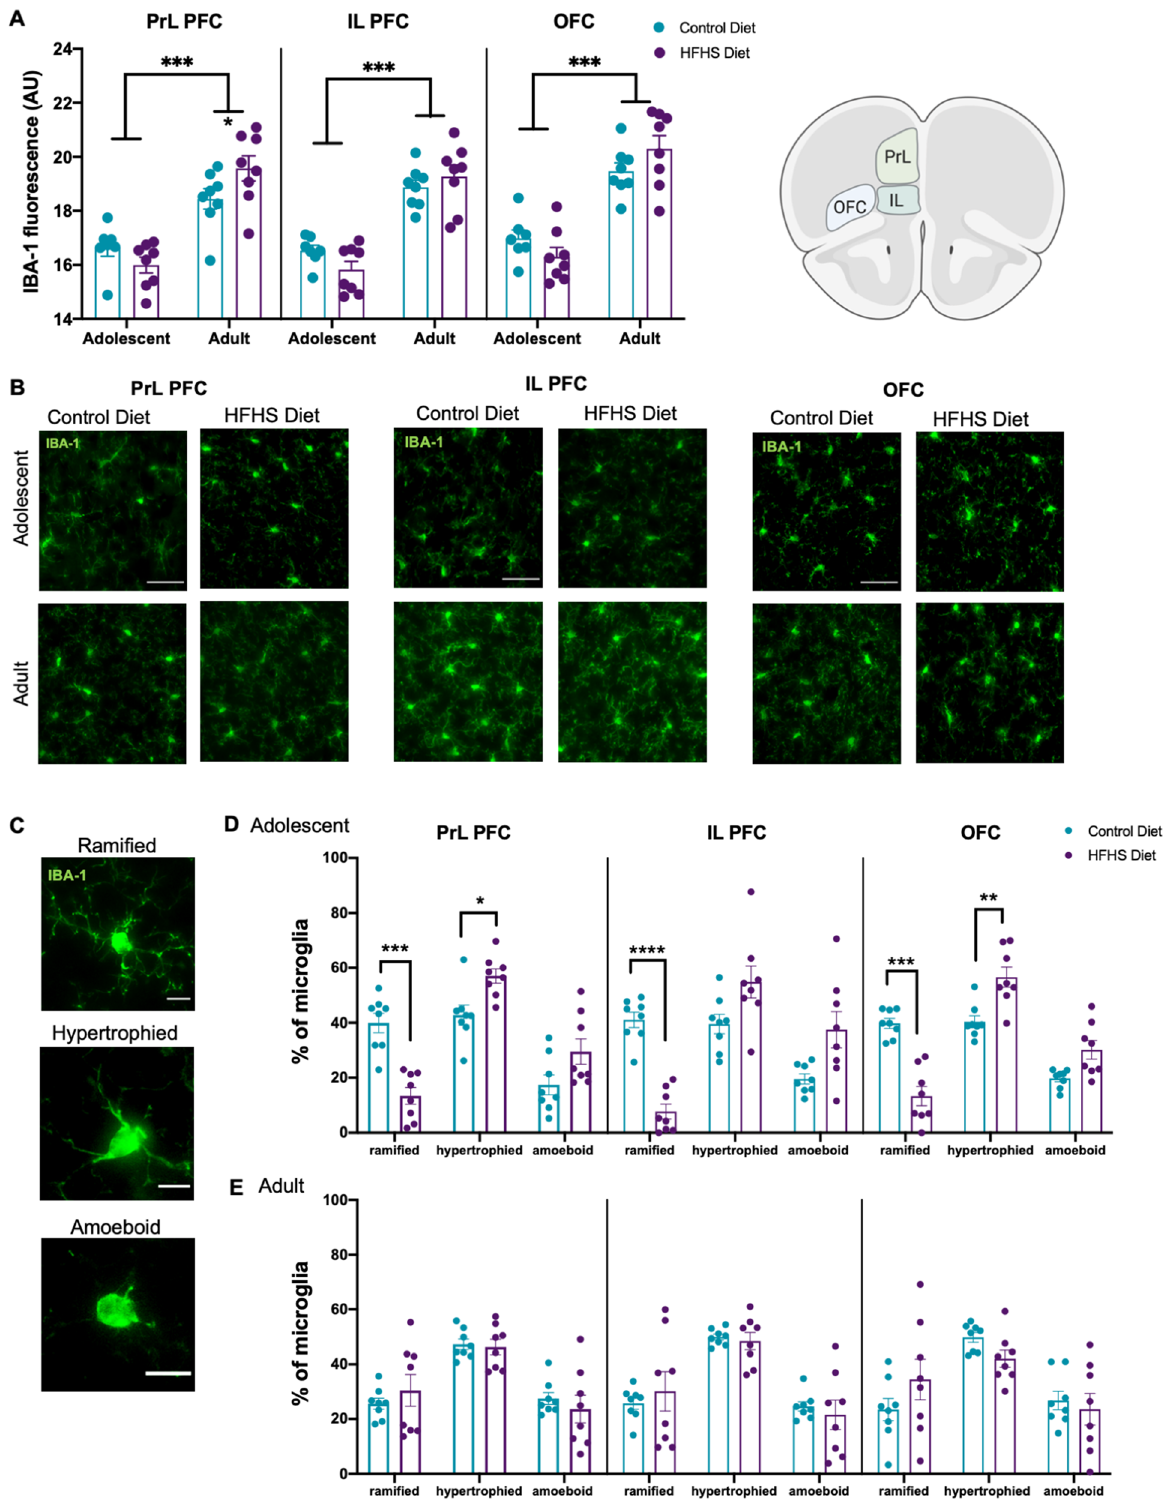
Figure 4. HFHS diet-evoked changes to PFC microglia density and morphology. Mice in the adult cohort had a significantly greater ( A , B ) IBA-1 fluorescence in all three prefrontal subregions. Consumption of the HFHS diet evoked a selective increase ( A , B ) in IBA-1 density in the PrL cortex in the adult cohort. Mice that consumed HFHS diet across adolescence had proportionally fewer ( C , D ) ramified ‘resting’ microglia in all three regions and more hypertrophied ‘active’ microglia in the PrL and OFC. In contrast, no diet-related changes ( C , E ) in PFC microglia morphology was seen in mice that consumed HFHS diet as adults. Data were assessed using two-way ANOVAs and * p < 0.05, ** p < 0.01, *** p < 0.001, **** p < 0.0001. Representative photomicrographs were taken at 40X magnification (green—IBA-1 + microglia), scale bars show 50 μm for IBA-1 + density and 10 μm for IBA-1 +